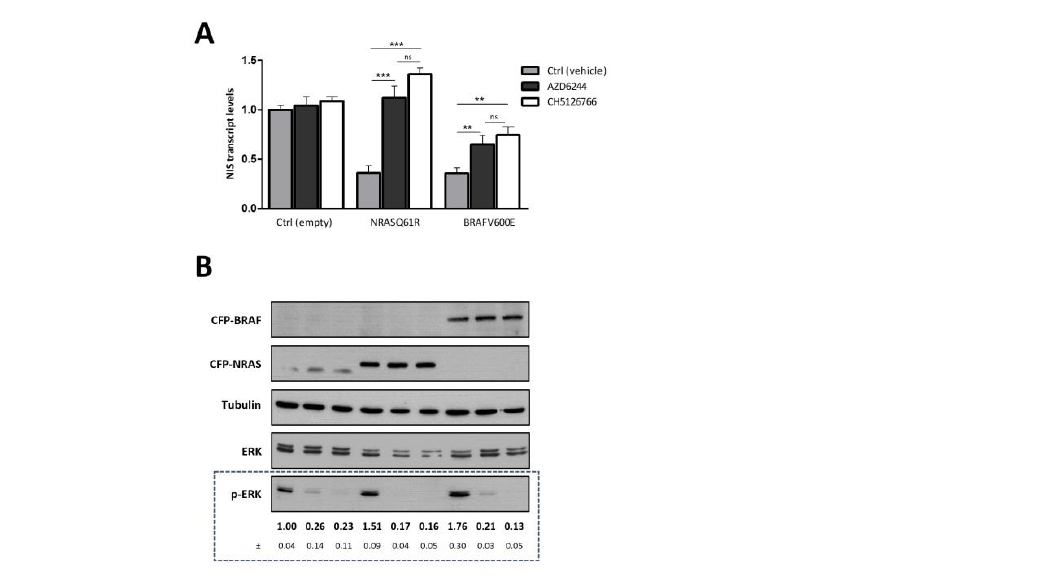
Figure 2. Effect of MEK1/2 inhibition on NIS transcriptional expression in thyroid cells expressing NRAS and BRAF gain-of-function mutants. ( A ) PCCL3 cells transduced as indicated were serum- starved for 24 h followed by stimulation with TSH (1 mU/mL for 48 h) in the presence or absence of either AZD6244 (10 µM for 48 h) or CH5126766 (10 µM for 48 h). NIS mRNA levels were quantified by RT-qPCR and plotted as fold differences relative to mock (CFP)-transduced cells, without treatment with the MEK inhibitors [Ctrl (empty)]. Values are means ± SEM of five independent assays. Comparisons were made using a two-tailed Student’s t -tests between AZD6244-treated or CH5126766-treated versus untreated setting (ns — not significant; ** p ≤ 0.01; *** p ≤ 0.001). ( B ) NRAS and BRAF expression was assessed by western blot using anti-GFP primary antibody. MAPK activation status was assessed by monitoring phosphorylated ERK 1/2 vs. total ERK 1/2 levels by western blot [quantified below the respective panel (means ± SEM of three independent assays)], using anti-phospho ERK 1/2 and anti-ERK 1/2 primary antibodies, respectively. Alpha-tubulin was used as loading control (see Figure S3 for uncropped WB).